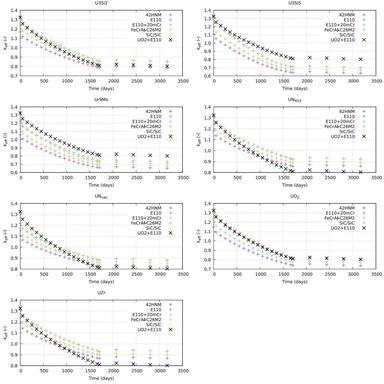
Multiplication factors of the fuel types with constant 4.5% fuel enrichment.